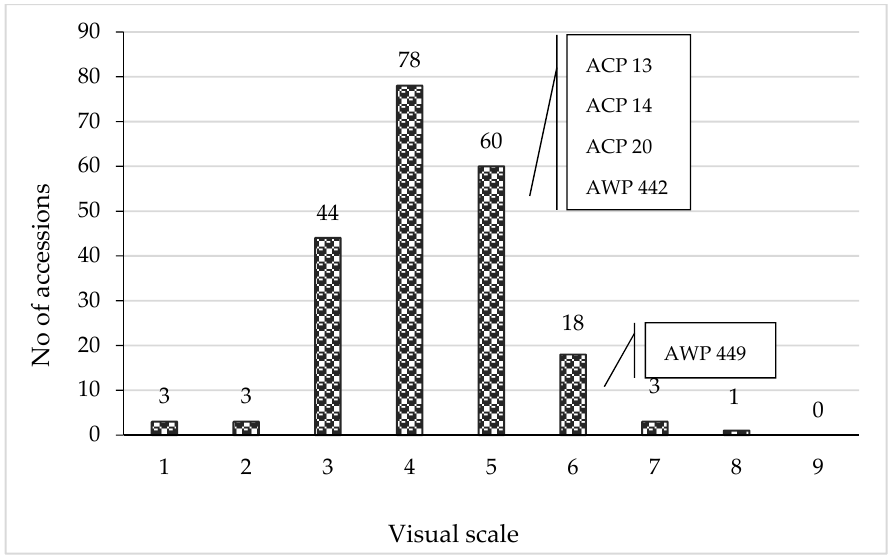
Figure 2. Resistance classes of pea accessions for the pea weevil based on a visual scale of 1–9 under field conditions.